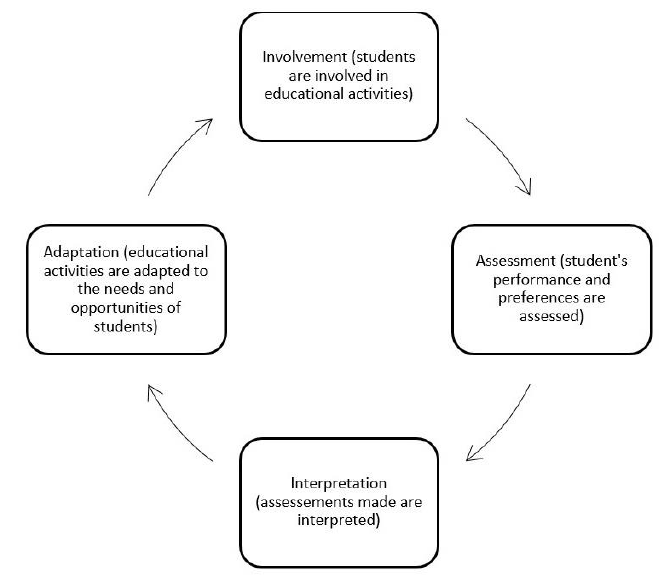
Fig. 1. Components of a personalized learning